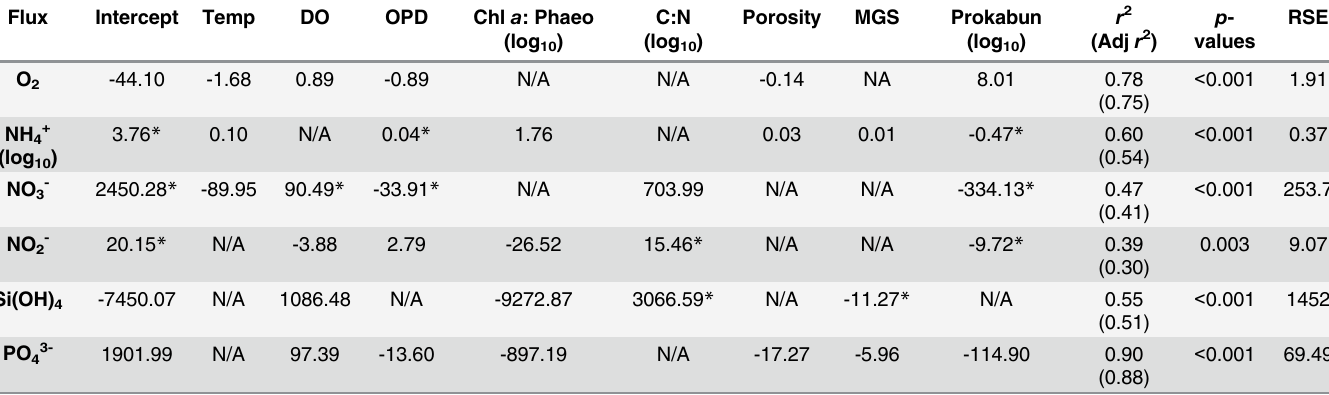
Table 5. Results of the multiple linear regression models based on AIC. Data utilize are from all sampling locations and dates. DO = Bottom water dis- solved oxygen concentration; OPD = Oxygen penetration depth; Chl a :Phaeo = Chlorophyll- a to phaeopigments ratio; C:N = Carbon-to-nitrogen